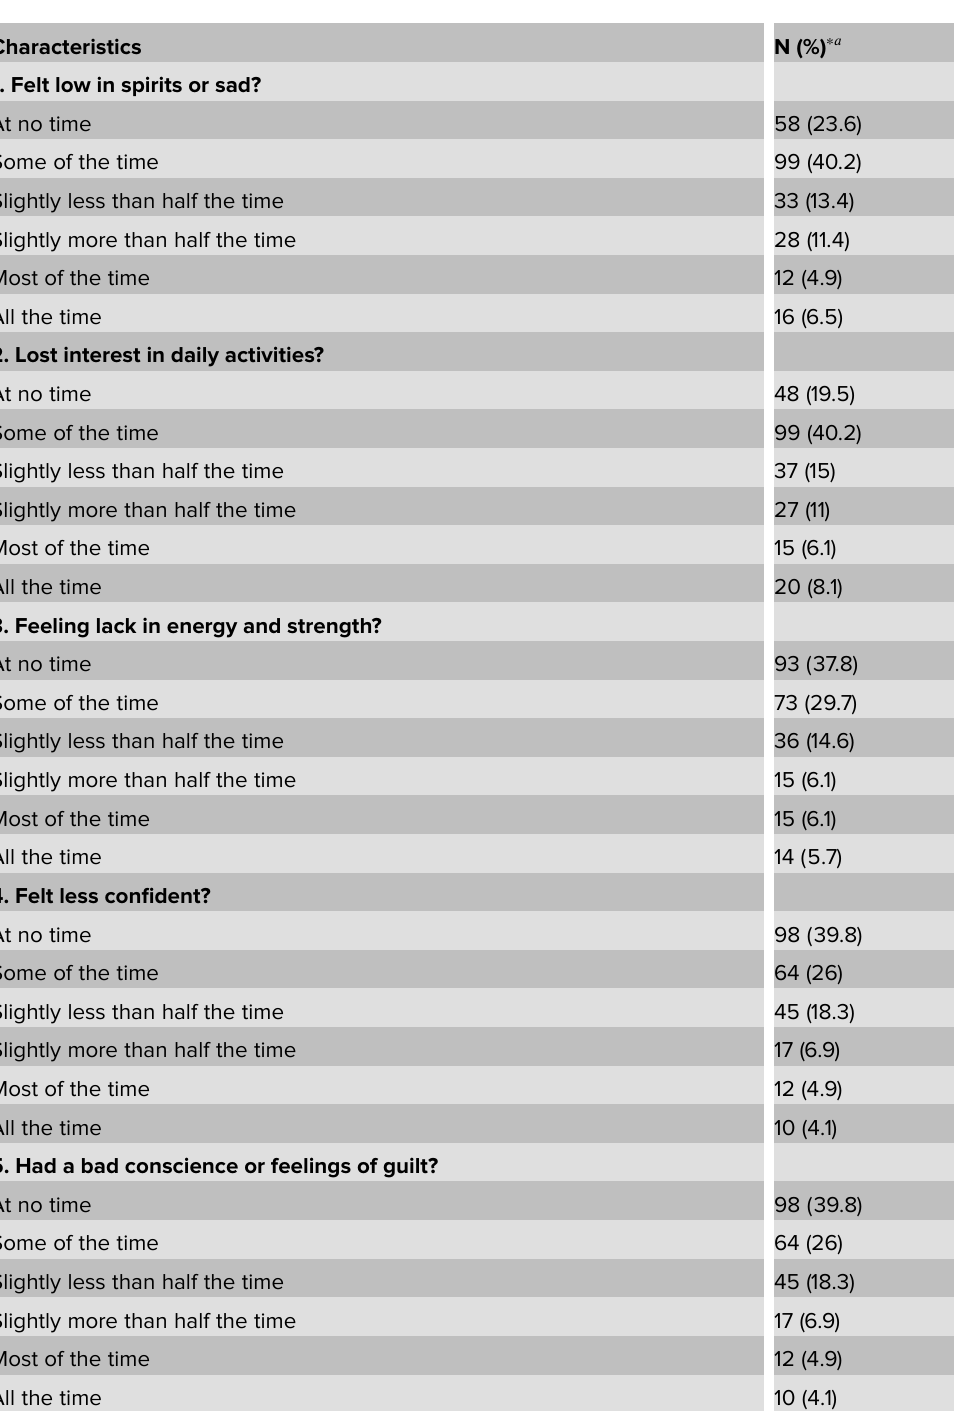
Table 3: MDI questions for